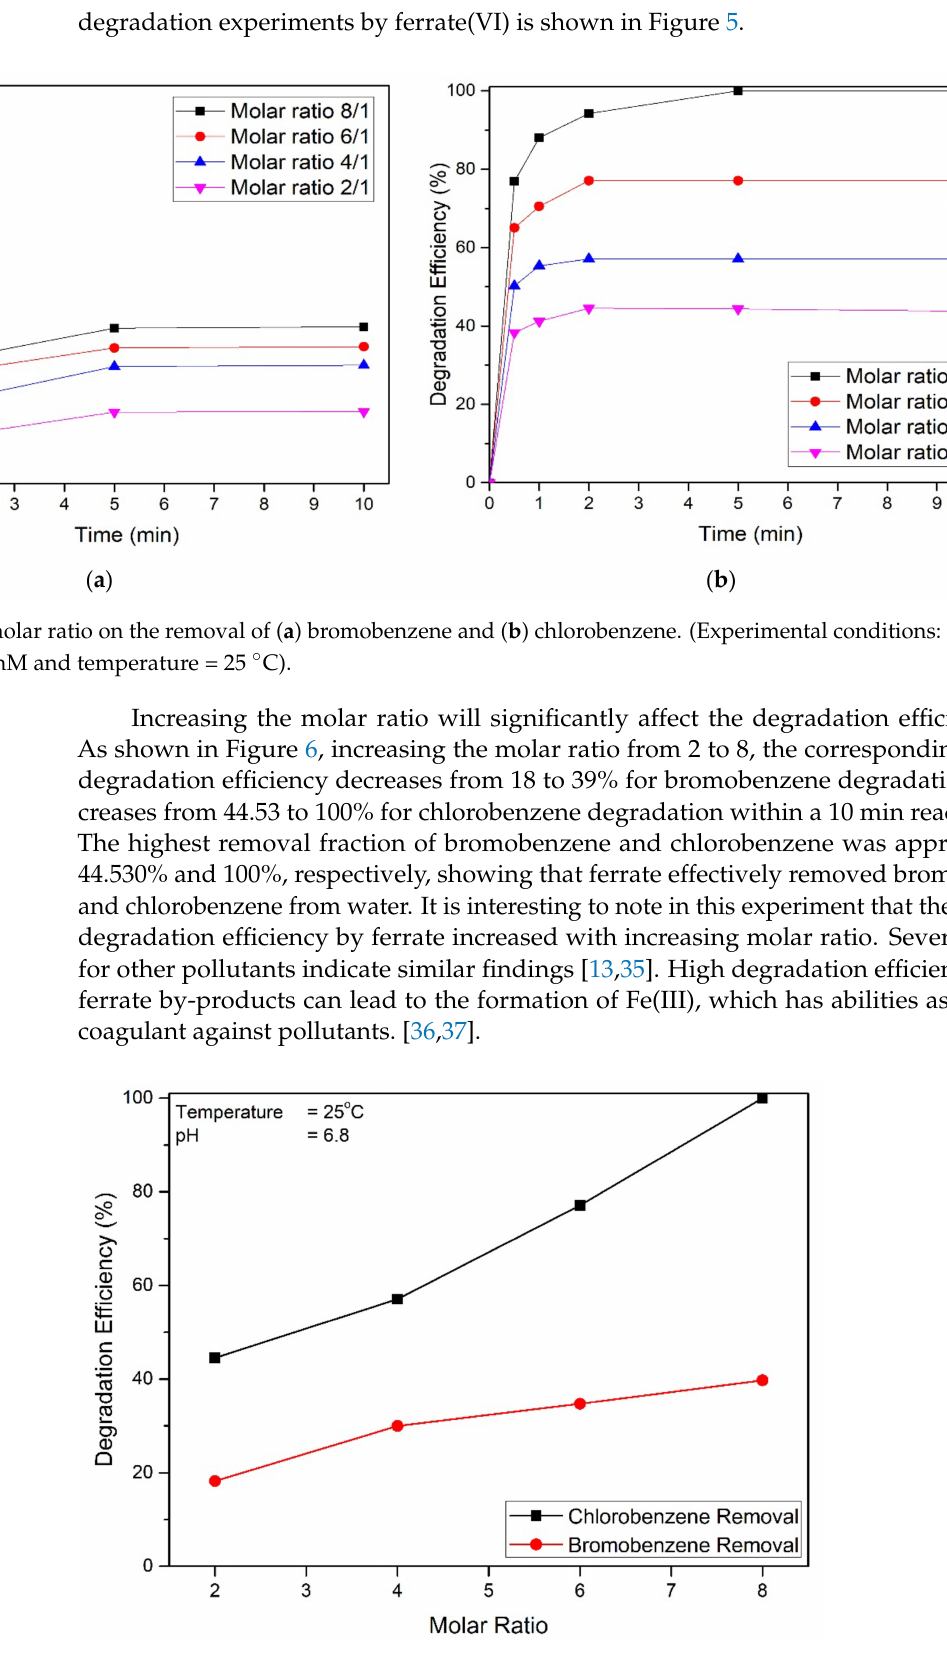
Figure 6. Relationship between molar ratio and degradation